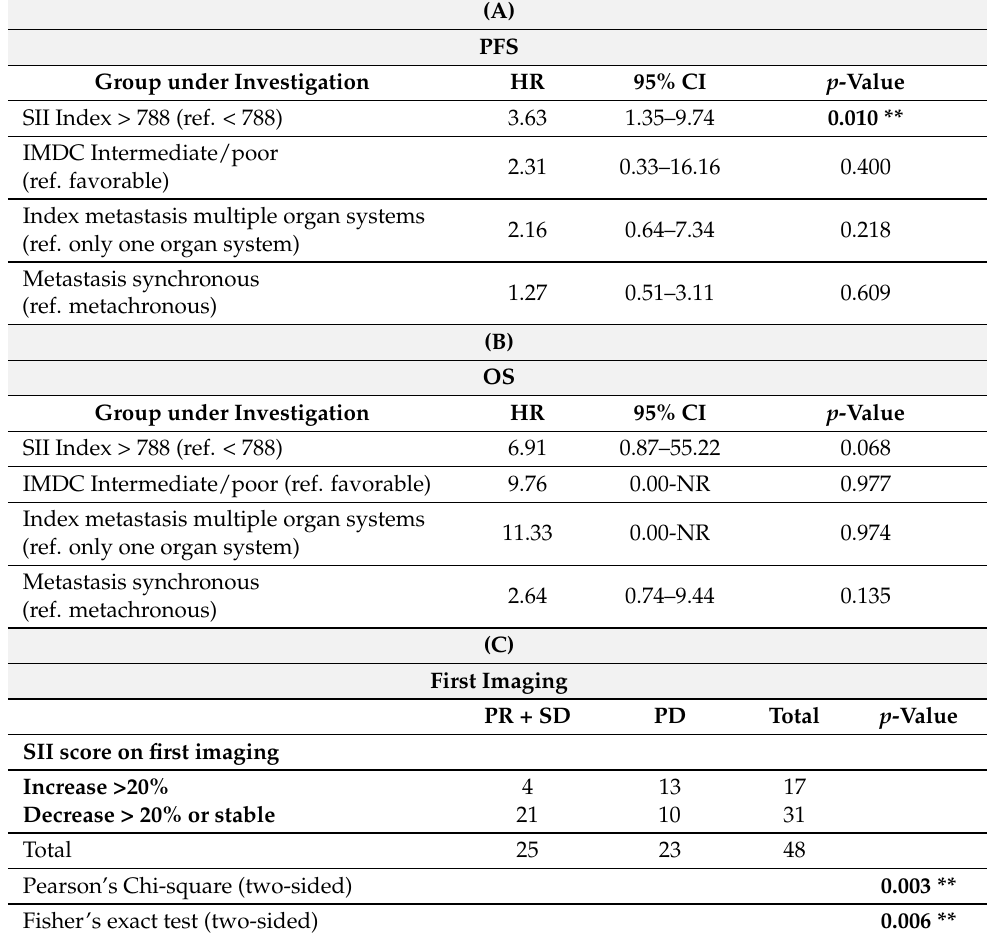
Table 3. Multivariate analysis of PFS ( A ) and OS ( B ) depending on clinical parameters and SII score. ( C ) Association of a change in SII (increase or decrease >20%) with treatment response at the time of initial imaging with ipilimumab plus nivolumab. An increase in SII of >20% above baseline at 12 weeks on therapy was significantly associated with tumor progression at initial imaging (chi-square test p =